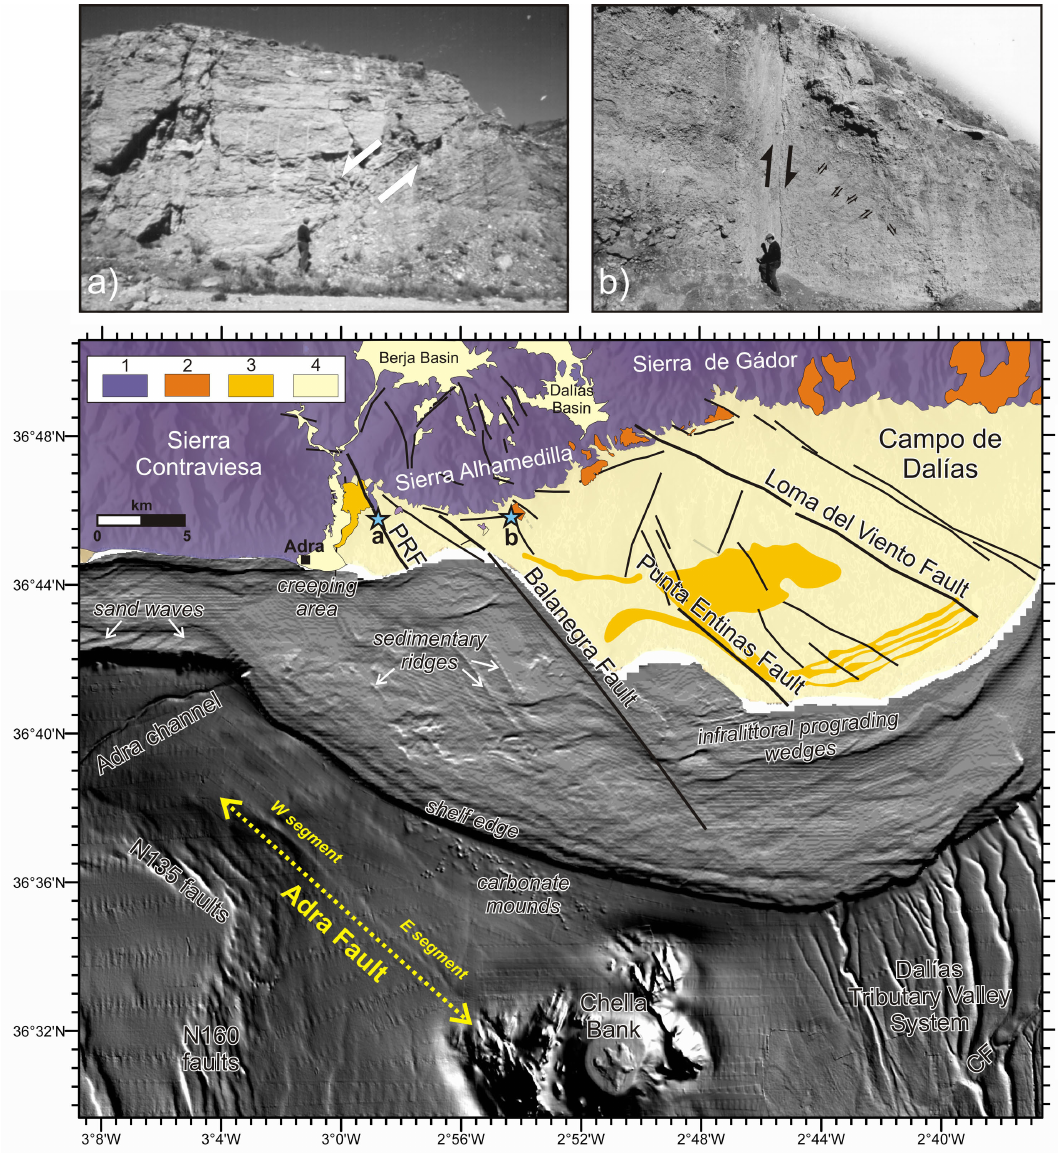
Fig. 2. Shaded relief bathymetric map of the Adra–Almer´ıa margin. The Adra Fault and segments are marked in yellow. Onshore, main structures and geological units are also depicted. They correspond to 1: Alboran Domain basement; 2: Upper Miocene deposits; 3: Pliocene deposits; and 4: Quaternary deposits (modified from Mart´ınez-D´ıaz, 1998; Sanz et al., 2004; Mar´ın Lechado et al., 2005; Fern´andez-Salas et al., 2009; Pedrera et al., 2012). PRF: Puente del R´ıo Fault; CF: Carboneras Fault. Blue stars depict location of pictures from insets. Insets: Field examples of normal faults from the Adra-Campo de Dal´ıas region. (a) The N155 Puente del R´ıo normal fault separating the deltaic Pliocene deposits from the grey Paleozoic phyllites on the footwall. (b) A N170 trending normal fault cutting a Pleistocene alluvial fan on the southern slope of Sierra Alhamedilla. The striae show pitch of 110 ◦ and dextral component (modified from Mart´ınez-D´ıaz,